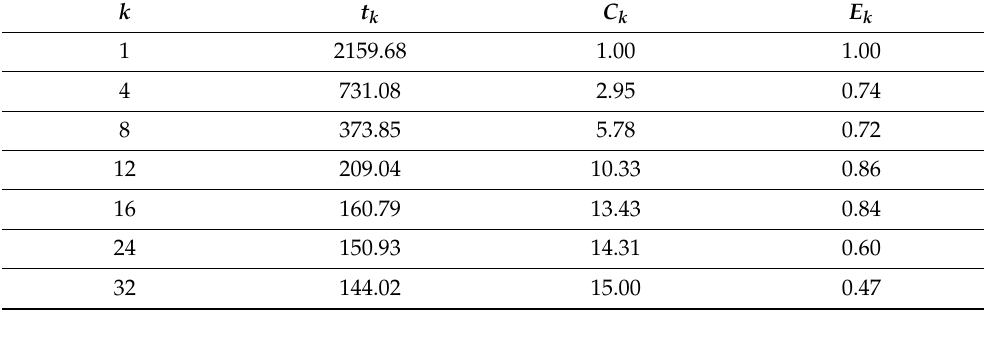
Table 1. Solution time, speedup and efficiency for a DCBP problem instance with 50 circles solved on the cluster SKIT-4.